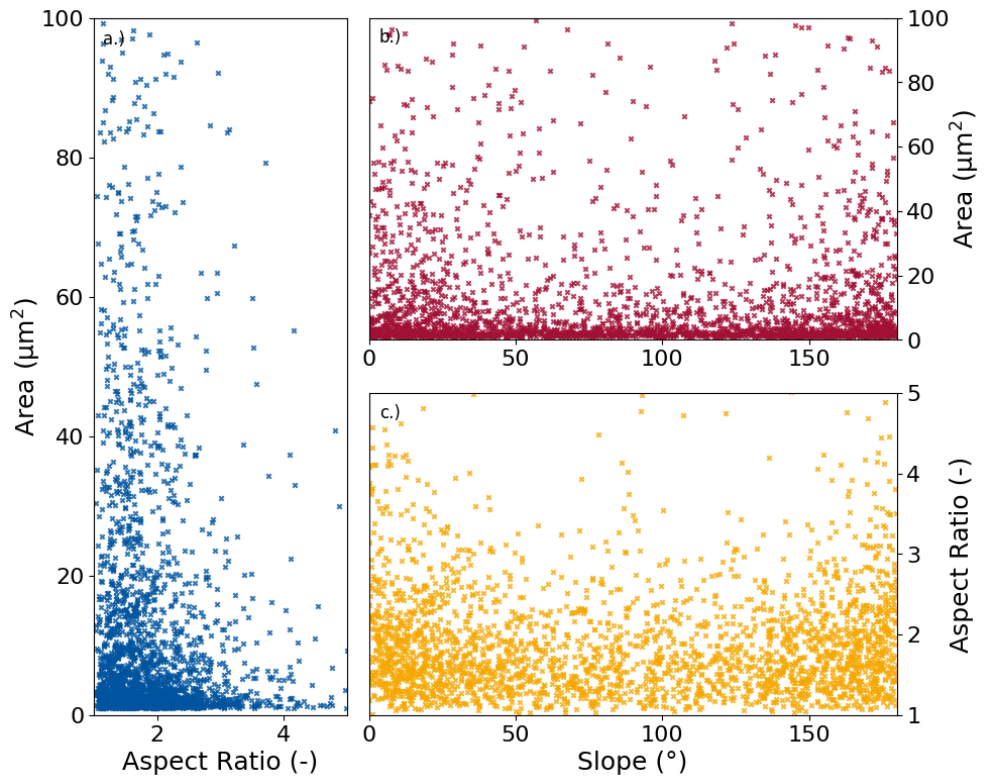
Figure 3. Scatter plots of the dependencies between the three main grain parameters, grain size and aspect ratio ( a ), grain size and slope ( b ), and aspect ratio and slope ( c